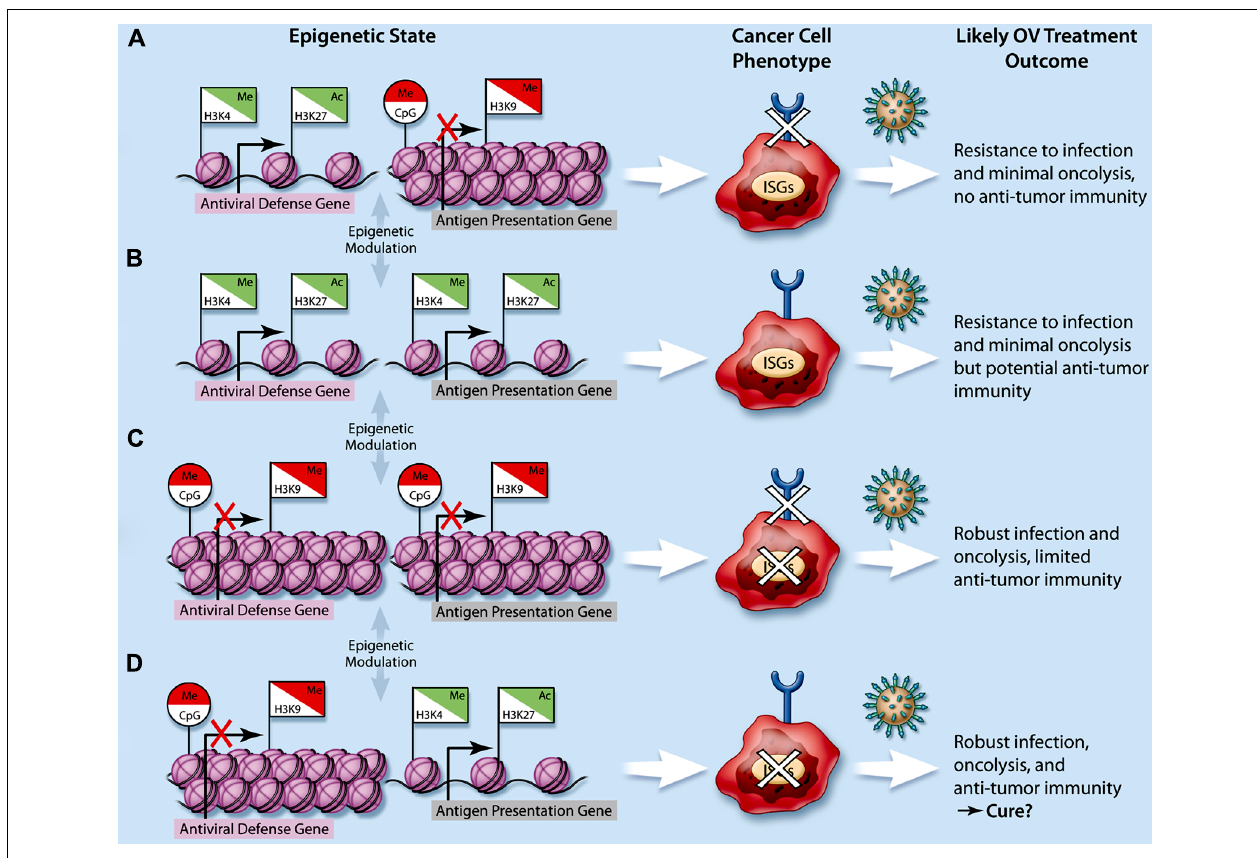
various possible epigenetic states with respect to genes involved in the antiviral response (e.g., type I IFN, interferon stimulated genes or ISGs) as well as those involved in antigen presentation (e.g., MHC I/II expression, represented by a semi-circle at the end of a stick).This ultimately leads to a variety of cancer cell phenotypes (A–D) and subsequently, a variety of potential therapeutic responses to oncolytic viruses (OVs, represented by spiked green